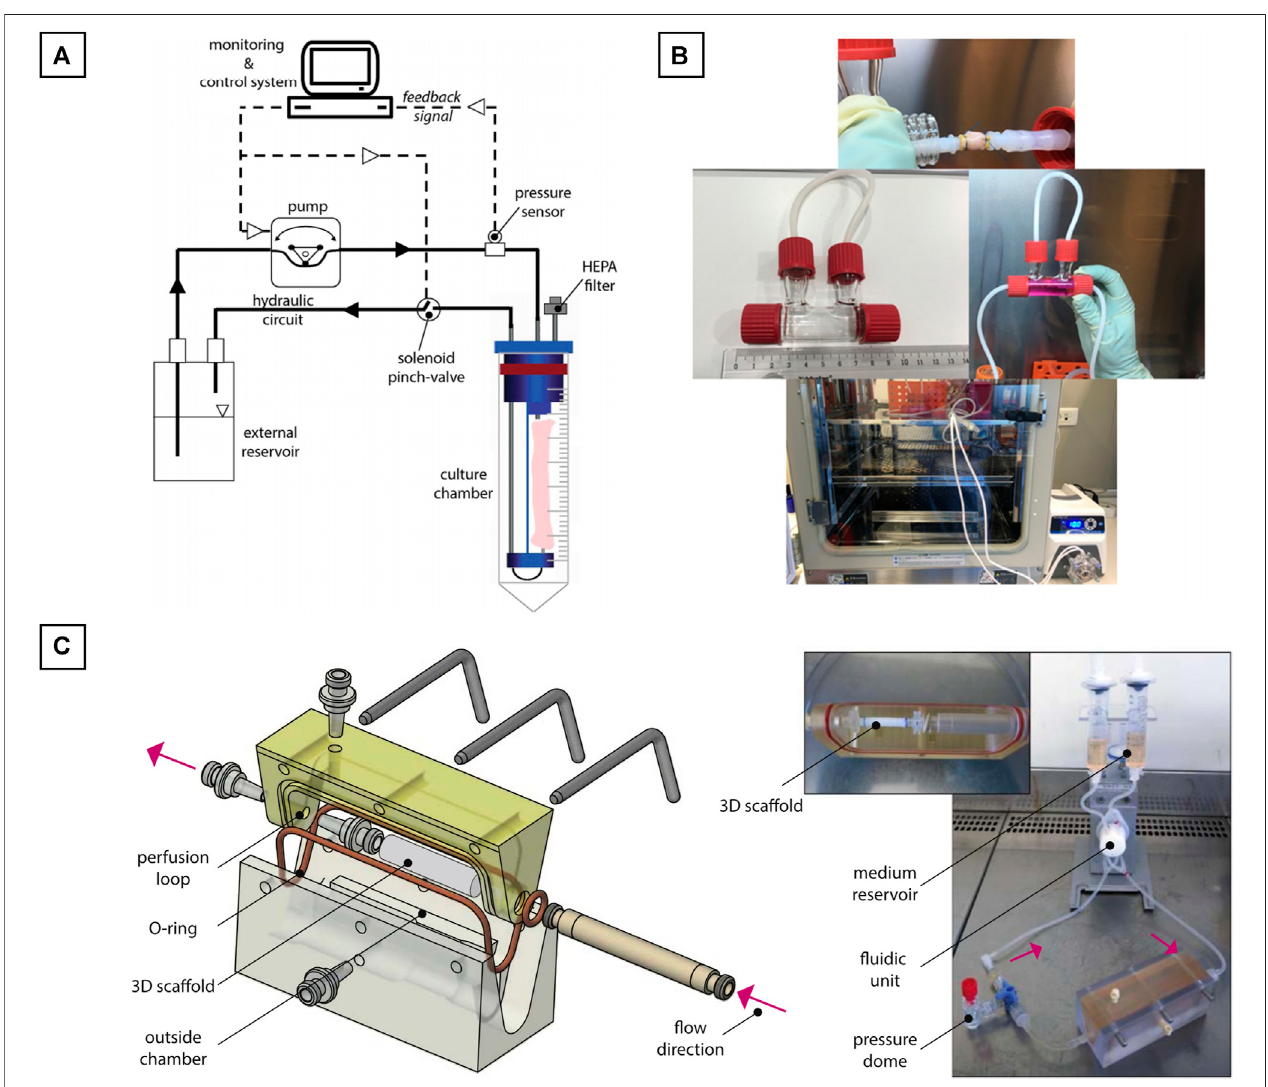
FIGURE9| Homemadebioreactorsideas. (A) Dual-modebioreactorsystem; (B) Perfusedbioreactorand (C) Perfusedbiorectorforabi-layeredvasculargraft.The image is adapted from the work of Bono et al. (2017), Çelebi-Saltik et al. (2021), and Pennings et al. (2020).